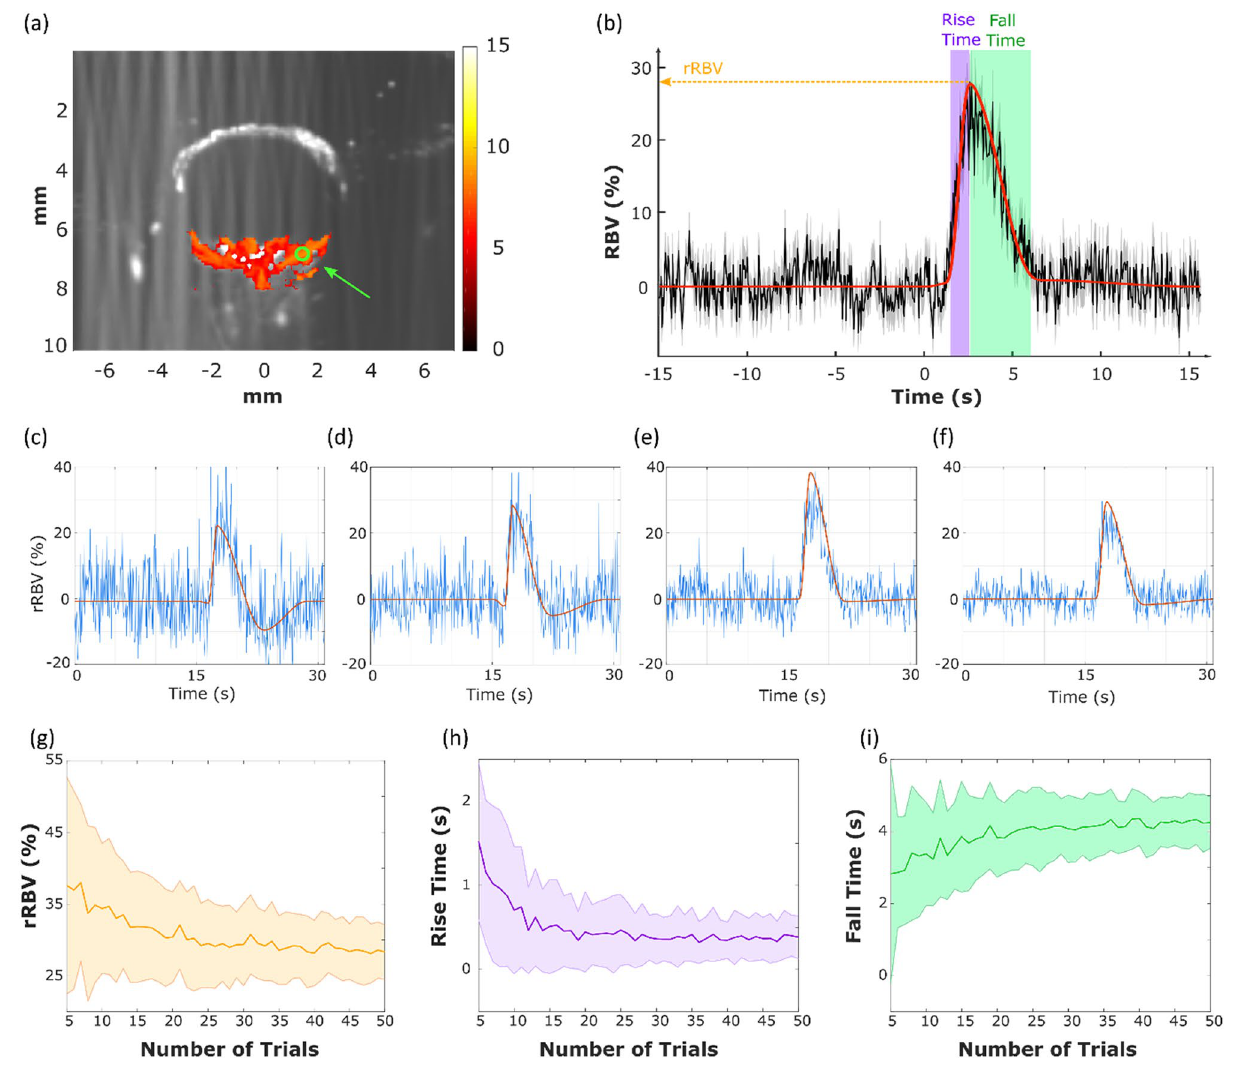
Figure 4. Robustness of the HRF Parameters . ( a ) Zscore activation map and automatic positioning of the ROI over the peak response ( b ) Average on all trials of the hemodynamic response (black curve) within the chosen ROI with its fitted hemodynamic response model (red curve). The relative amplitude, rise time, and fall time are extracted from the fitted hemodynamic response model ( c ) Examples of hemodynamic responses for four individual trials (blue curves) and their associated fitted model (red curves). ( g )–( i ) Evolution of the mean and standard deviation of the relative retinal blood volume, rise and fall times parameters depending on the number of stimuli performed, estimated using a bootstrap